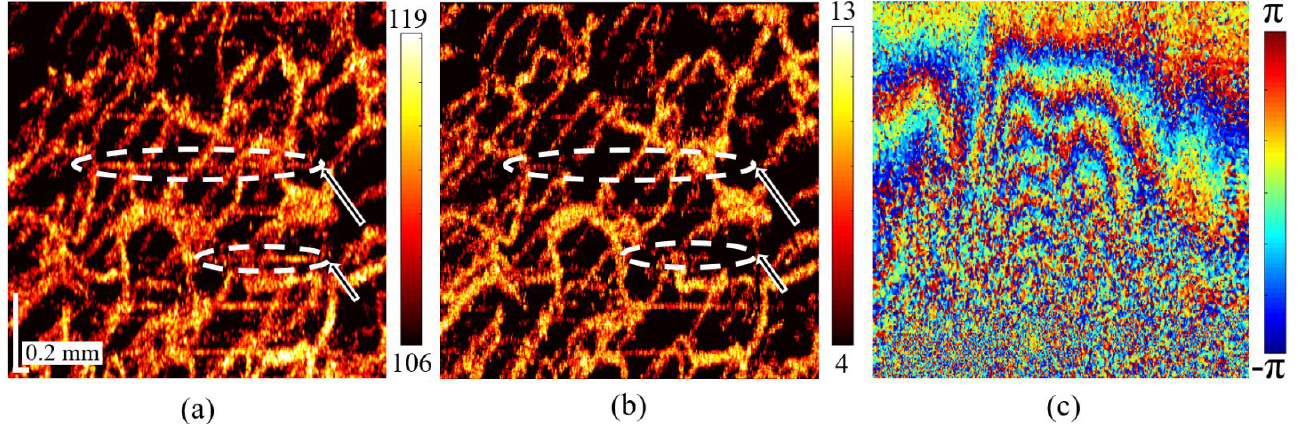
Figure 8. Comparison of high pass filtration ( a ) and OCA-S ( b ) methods for experimental data. The experimental results are presented as en face images using logarithmic scale. The OCA-S image has fewer artefacts, which are indicated by white dashed ellipses. The interframe phase difference corresponding to higher ellipse is shown on panel ( c ). The scale bar is 0.2 mm.